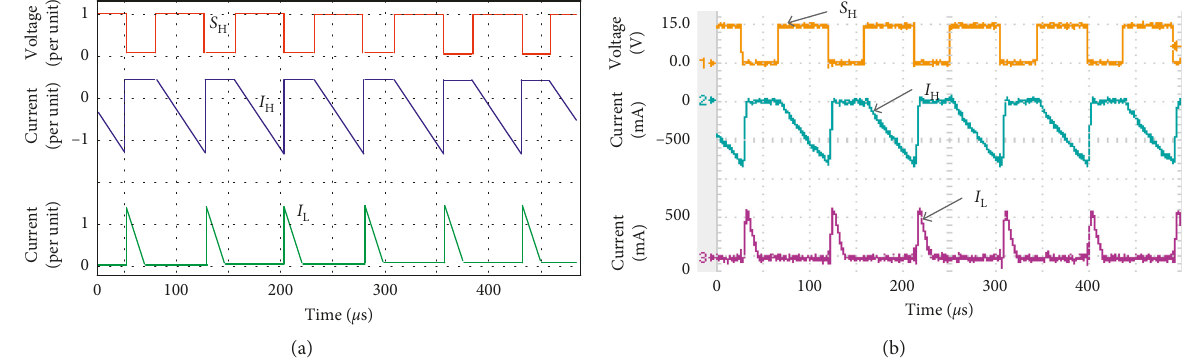
Figure 10: The dynamic characteristics of the battery equalization process: (a) simulation and (b) experiment.